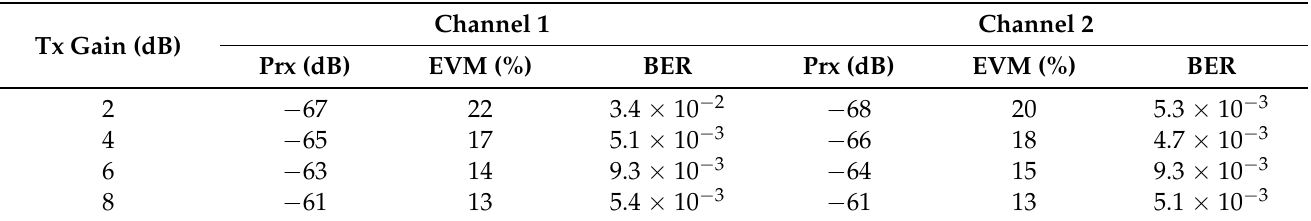
Table 2. The 2 × 2 near-field MIMO BER and EVM measurements in the metal enclosure. A maximum power gain of AGC was set to 80 and the RF frequency was 5.6